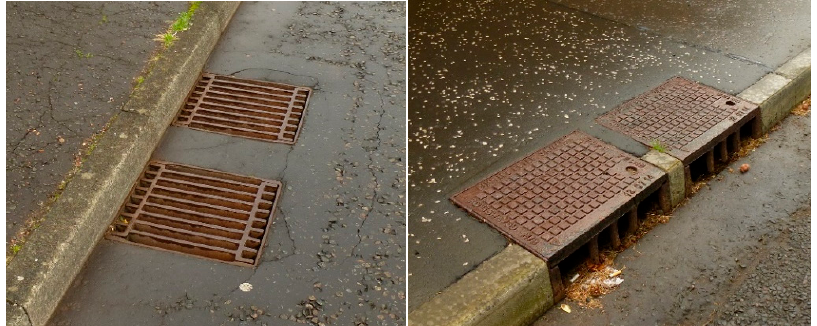
Figure 1. Examples of typical storm drain inlets.